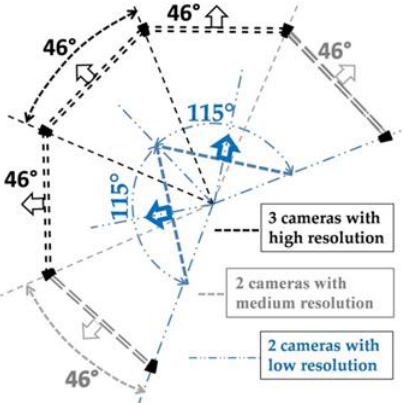
Figure 13. A potential technical eye mounted in a fixed way on the vehicle body; it has seven cameras with three resolutions.